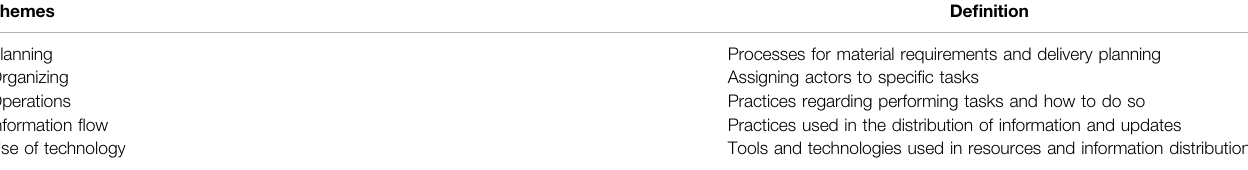
TABLE 3 | Logistics themes determined for this study.